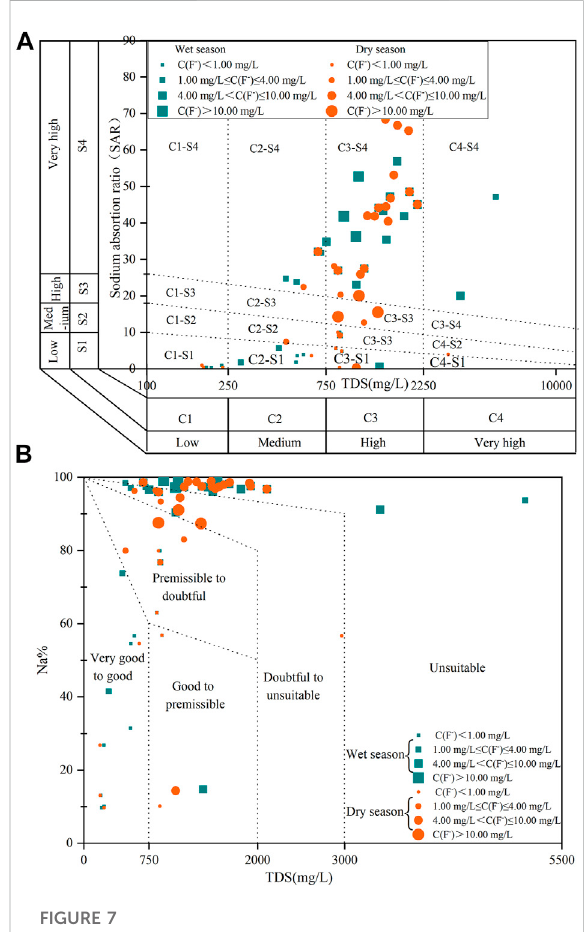
FIGURE 7 The plots of: (A) USSL classi fi cation of irrigation quality; (B) Wilcox of irrigation groundwater quality in the study